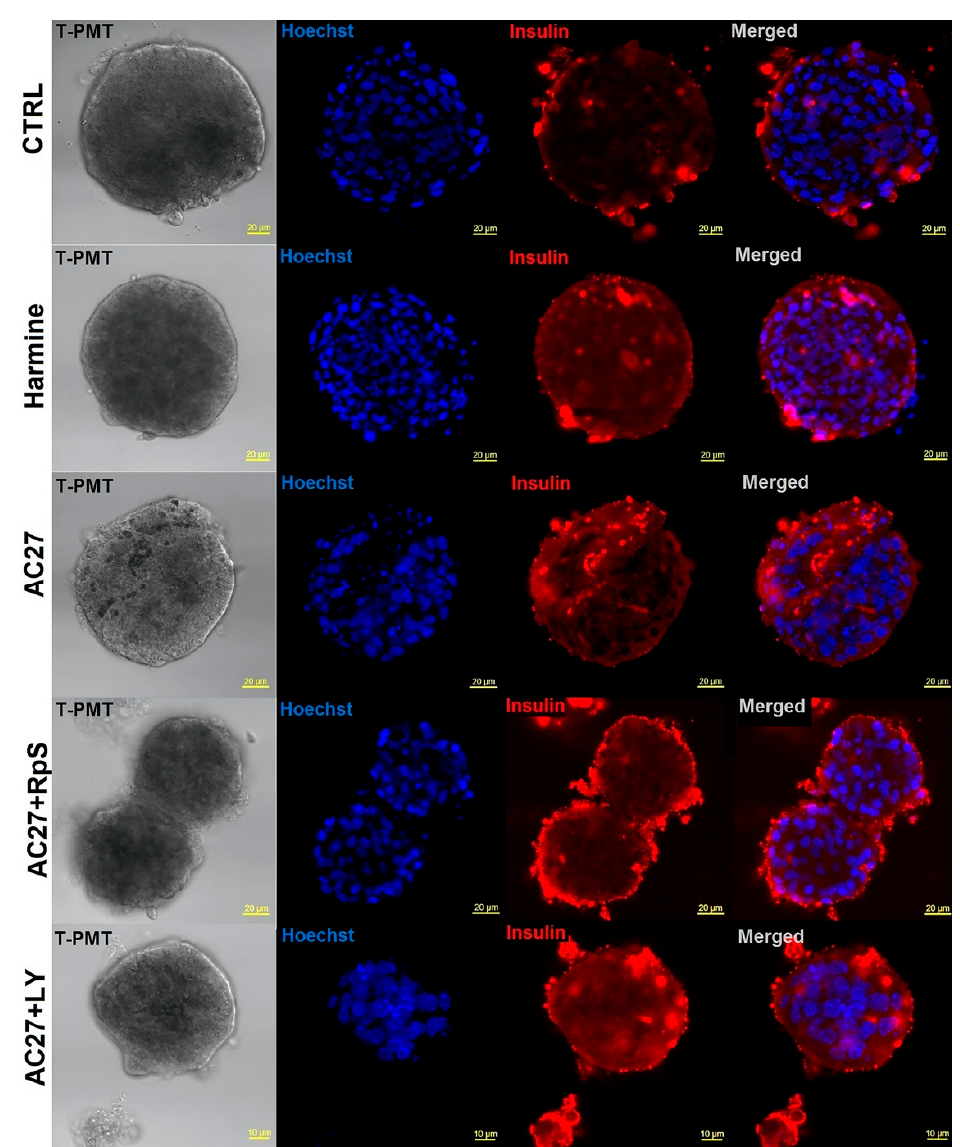
Figure 13. Representative insulin immunostaining of untreated islets after GSIS, and islets treated with harmine, AC27 alone, the AC27-LY364947 and the AC27-RepSox combination (red: insulin, blue: Hoechst 33342), scale bars, 5 μ m and 10 μ m.